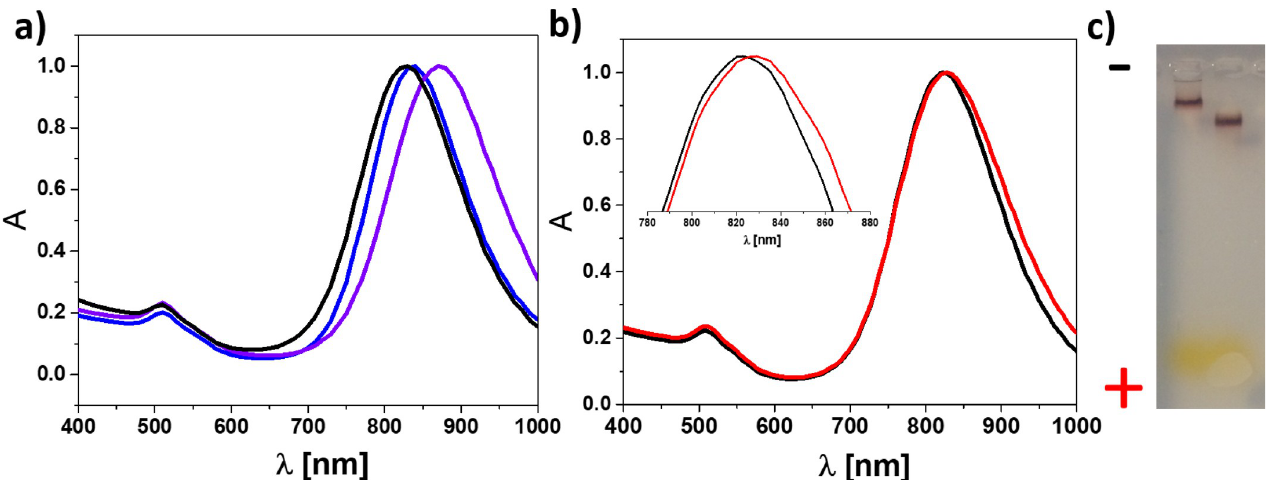
Fig 1. Conjugation of A β antibody to gold nanorods. a) Normalised absorption spectra for CTAB-capped gold nanorods (in water, blue), dodecylamine- capped gold nanorods (in chloroform, violet) and PMA-coated gold nanorods (in water, black). b) Normalised absorption spectra for gold nanorods after PMA coating (PMA-GNRs, black) and after conjugation with A β antibody (Abs-GNRs, red). Inset shows normalized data for the LSPR shift of Abs-GNRs. c) Gel electrophoresis of gold nanorods before (right lane, PMA-GNRs) and after (left lane, Abs-GNRs) conjugation with A β antibody.